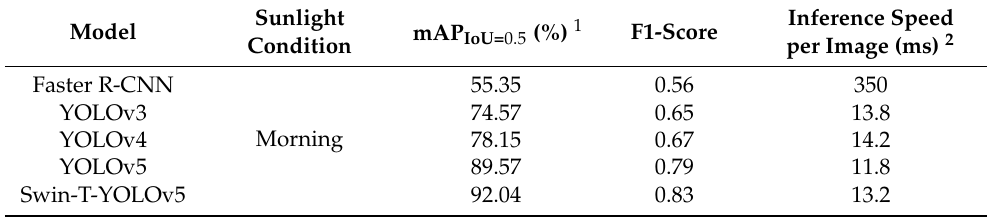
Table 7. Model comparison using the test set under three sunlight directions and